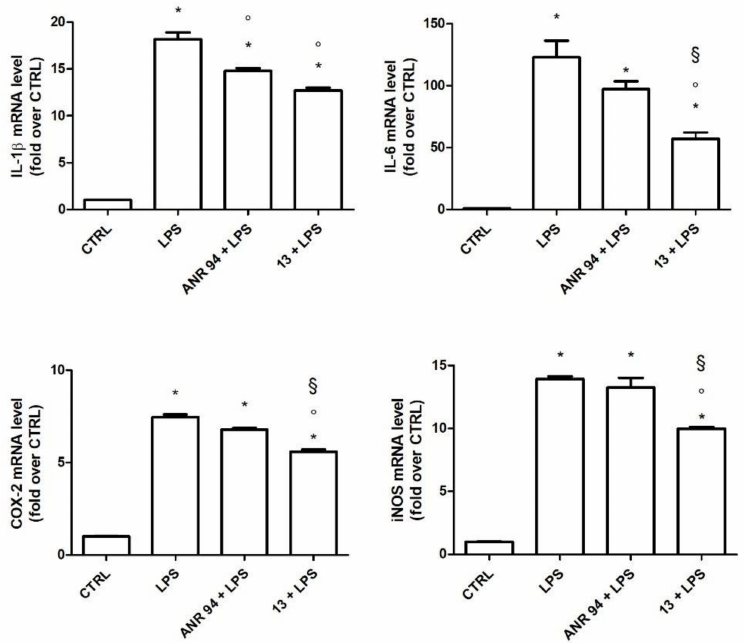
Figure 5. Expression of IL-1 β , IL-6, COX-2, and iNOS in BV-2 cells treated with 13 and ANR 94. Cells were treated with 10 nM 13 or 10 nM ANR 94 for 24 h, exposed to 100ng/mL LPS for 24h and cytokines and enzymes mRNA levels were measured by RT-PCR. Data are expressed as relative abundance compared to untreated cells. Each bar represents the mean ± SEM of three independent experiments. Data were analyzed with one-way ANOVA followed by Bonferroni’s test. * p < 0.05 vs. CTRL; ◦ p < 0.05 vs. LPS; § p < 0.05 vs. ANR 94 +